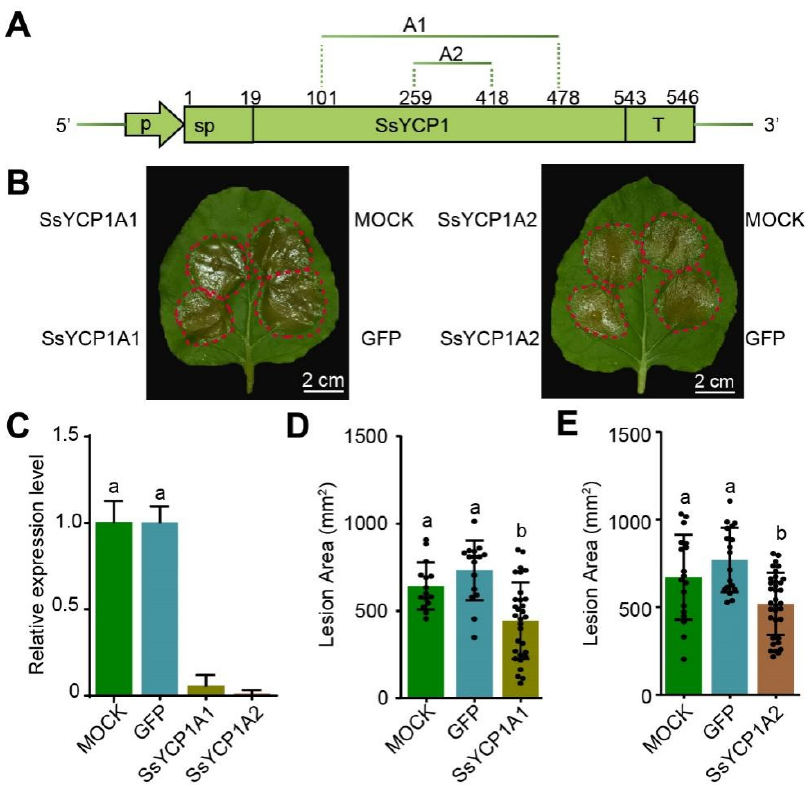
Figure 3. Silencing SsYCP1 reduces S. sclerotiorum pathogenicity. ( A ) Schematic diagram of SsYCP1 dsRNA-targeting regions. p: promoter, sp: signal peptide, A1 (101–478 bp), A2 (259–418 bp) represent two dsRNA, t: terminator, 5 ′ : 5 ′ UTR, 3 ′ : 3 ′ UTR. ( B ) S. sclerotiorum caused smaller lesions when SsYCP1 was silenced by dsRNA. dsRNA (SsYCP1A1 and SsYCP1A2) were transcribed in vitro and mixed with S. sclerotiorum mycelium suspensions for inoculation. S. sclerotiorum mycelium suspensions mixed with equal volumes of RNase-free ddH 2 O (mock) or with equal concentrations of dsRNA-targeting GFP (GFP) were used as negative controls. Leaves were photographed after 48 h and representative images are shown. ( C ) Expression of SsYCP1 was knocked down by dsRNA. The expression of SsYCP1 in leaves of Figure B was examined by qPCR. Data are means ± SD; n = 3; Different lowercase letters means p < 0.05 (one-way ANOVA followed by Duncan’s test). ( D , E ) Quantification S. sclerotiorum -induced lesions on leaves of ( B ). Lesion sizes were measured by ImageJ. Data are means ± SD; n = 20; Different lowercase letters means p < 0.05 (one-way ANOVA followed by Duncan’s test).